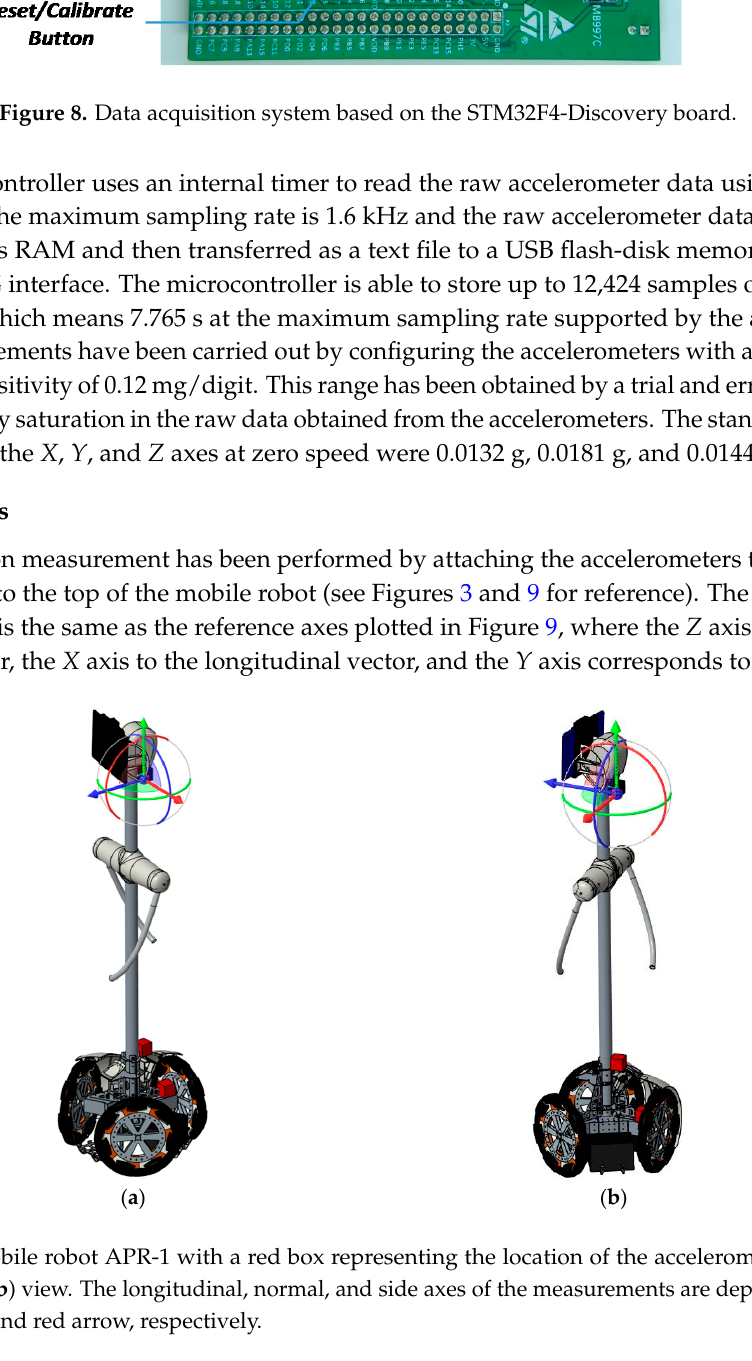
Figure 9. Mobile robot APR-1 with a red box representing the location of the accelerometers: front ( a ) and side ( b ) view. The longitudinal, normal, and side axes of the measurements are depicted with a blue, green, and red arrow, respectively.